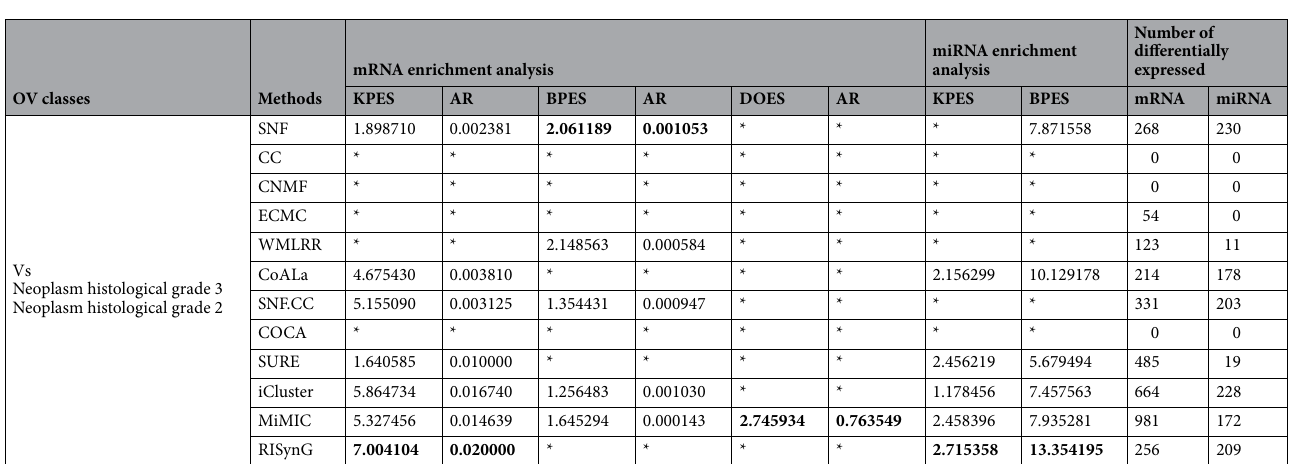
Table 7. Comparative biological analysis of OV dataset. The bold values indicate the best score as reported in the